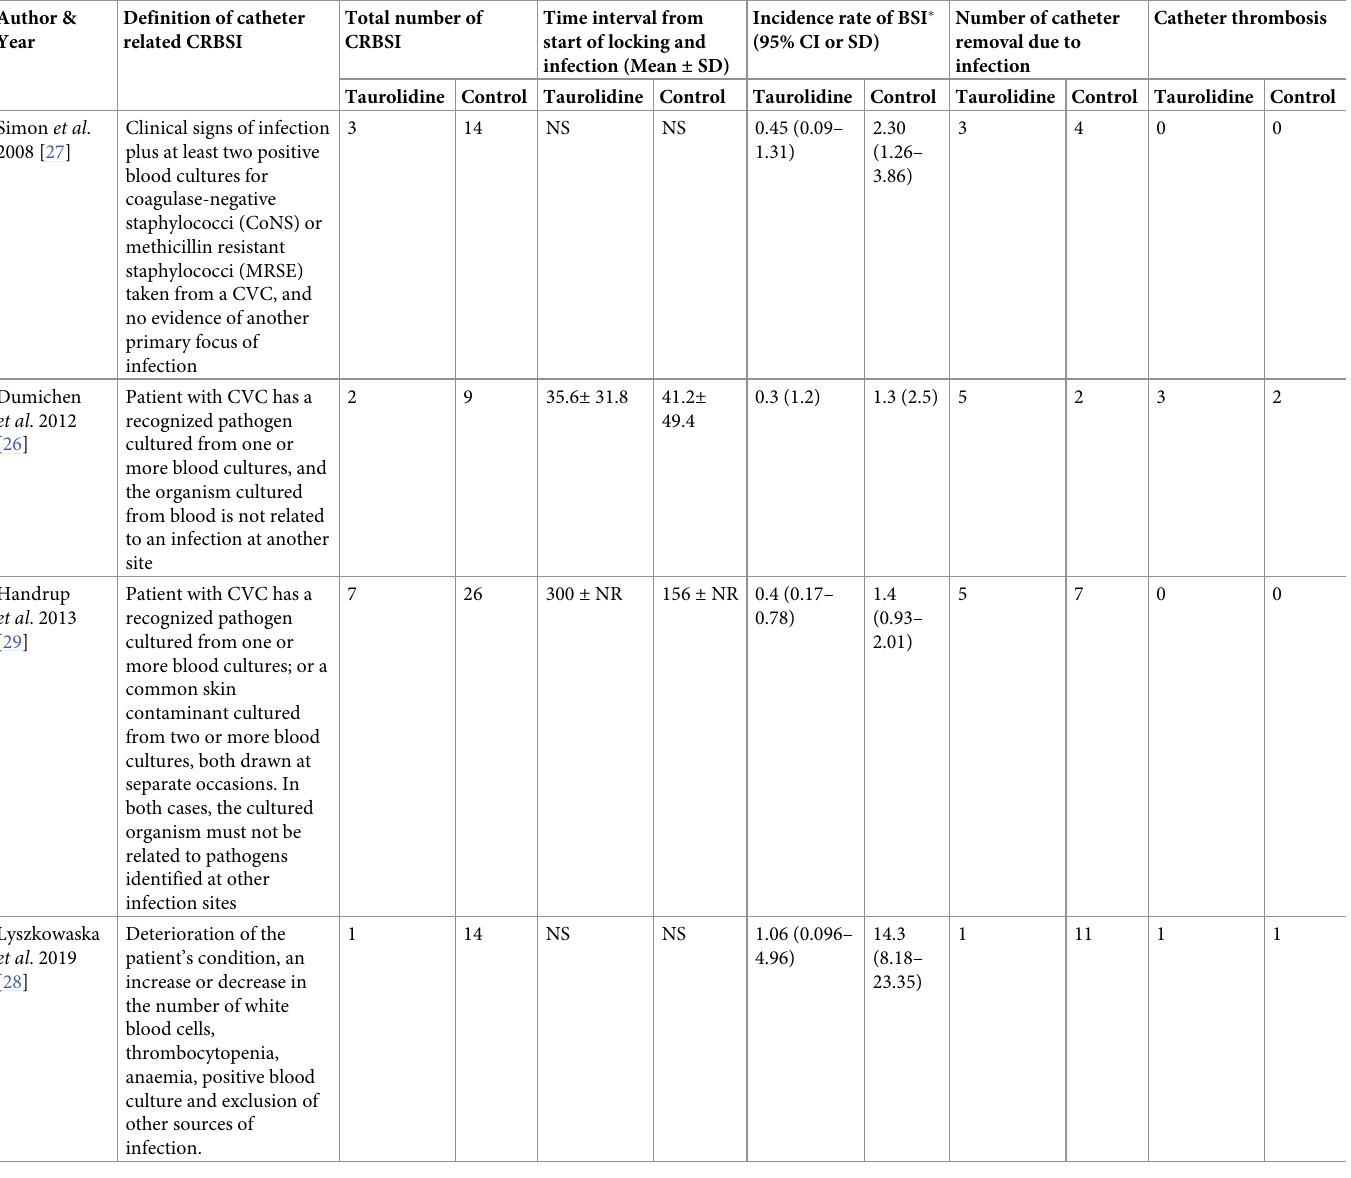
Table 2. Definition and outcomes in included